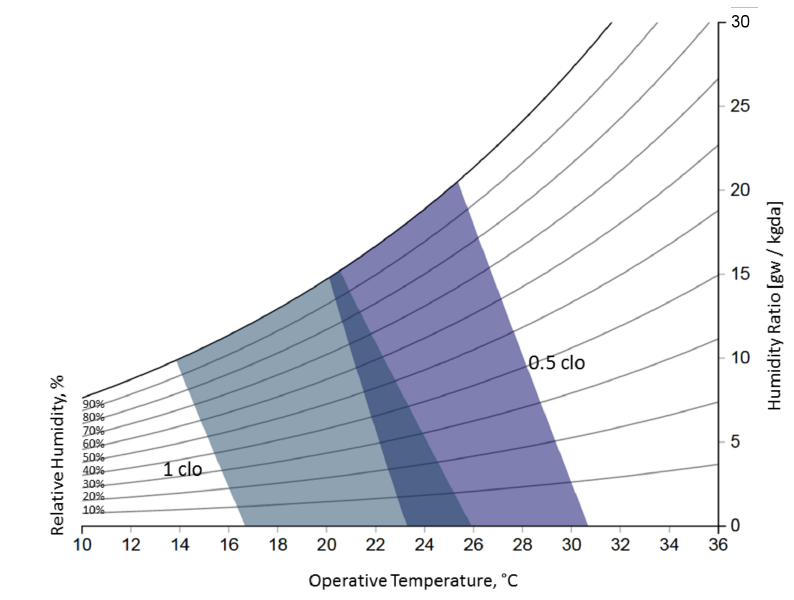
Figure 1. Acceptable range of operative temperature and humidity ratio based on ASHRAE Standard 55 [11]. The chart was created using the Center for the Built Environment (CBE) Thermal Comfort Tool [48]. clo, clothing